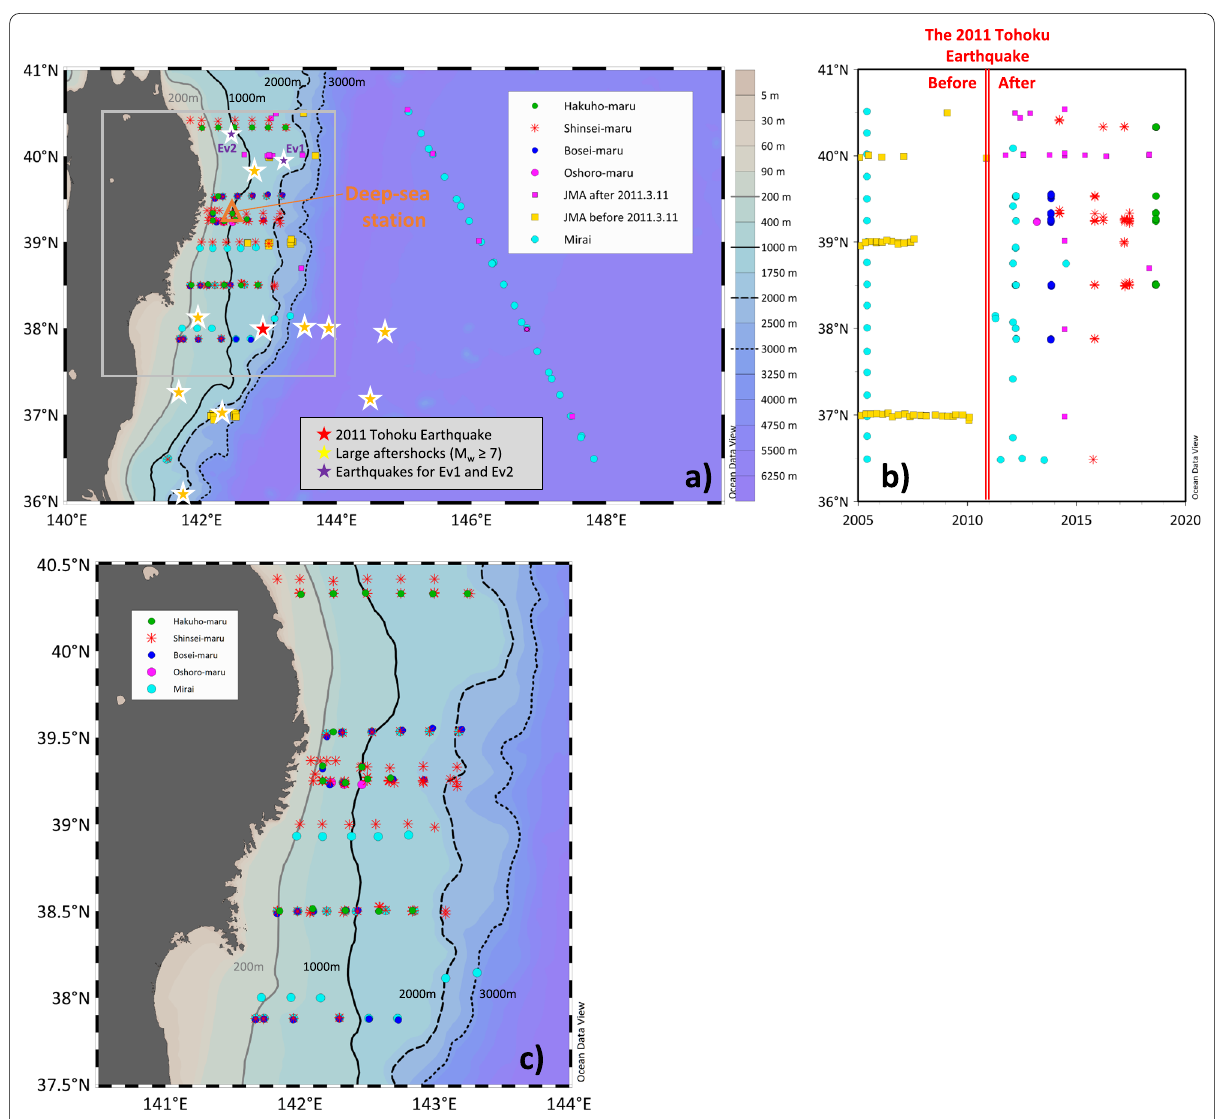
Fig. 1 Location map and bathymetry ( a ), and time series as a function of latitude of location ( b ) of sampling stations in this study. ( c ) Location map of our sampling stations (Table 1) encircled by the square in panel ( a ). The hypocenter of the 2011 Tohoku Earthquake is shown by the red star, and the hypocenters of large aftershocks (M w 7) until 2019 in the northern and southern limits of the aftershock region and the earthquakes for the ≥ Ev1 and Ev2 are shown by yellow and purple stars, respectively. Ship-based hydrographic observations were performed onboard research vessels [ Mirai (aqua-blue circles), Shinsei-Maru (red asterisks), and Hakuho-Maru (green circles) of JAMSTEC] and Japanese training ships [ Oshoro-Maru (pink circles) of Hokkaido University and Bosei-Maru (blue circles) of Tokai University], and by the JMA before (yellow squares) and after (pink squares) the 2011 Tohoku Earthquake. The open orange triangle denotes the deep-sea station (~ 1000 m depth) used for long-term monitoring of the seafloor on the continental slope (Oguri et al. 2016, 2018). Bathymetric contours show 200 m depth (solid gray line), 1000 m depth (solid black line), 2000 m depth (dashed black line), and 3000 m depth (dotted black line). The color bar shows the depth of